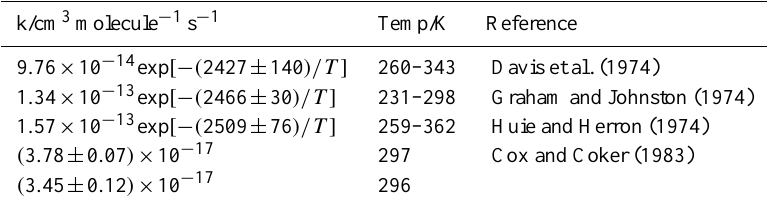
Table 1. Table summarising main laboratory measurements of Reaction (R2) given by NO 2 +O 3 (2004). The recommended value of k in DeMore et al. (1997) is based on a least squares fit analysis of the data presented in the first three studies listed below.